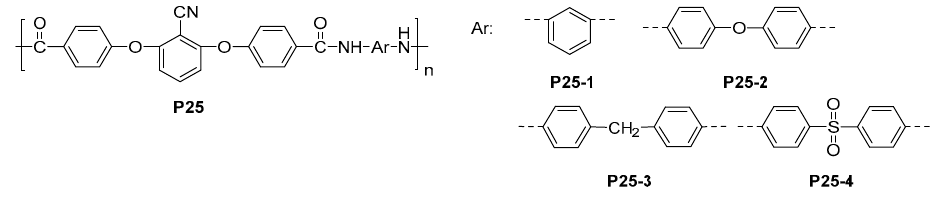
Table 2. Summary of the mechanical